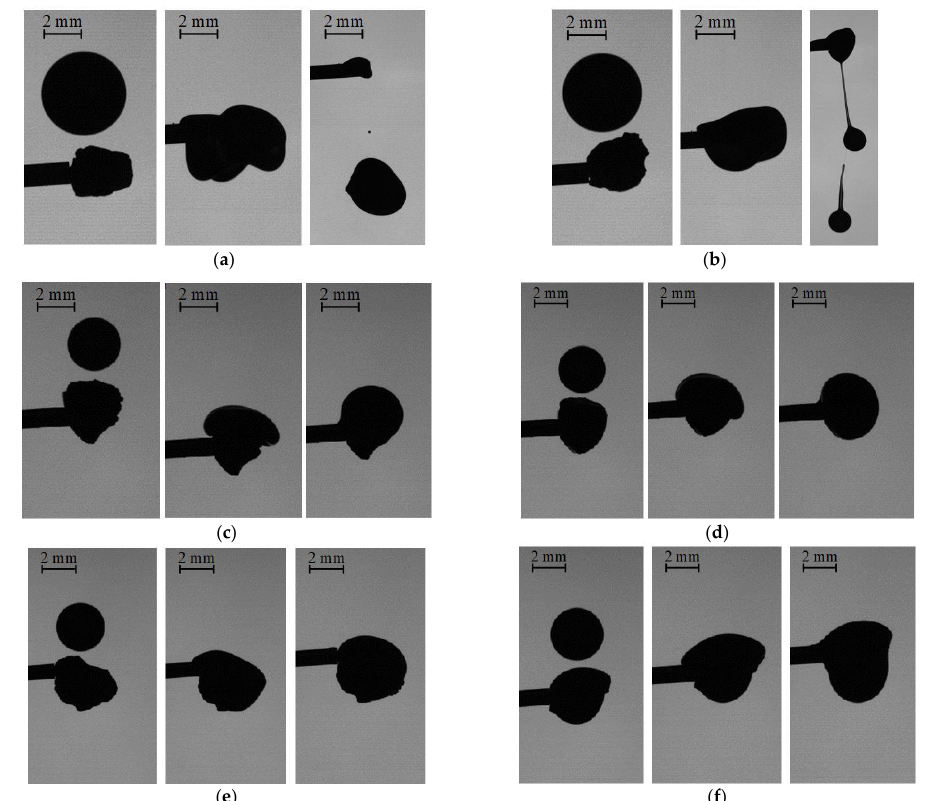
Figure 7. Images of collisions of used motor oil droplets with carbonaceous particles of anthracite at varying droplet sizes: ( a , c , e )—dry particles; ( b , d , f )—particles containing water on the surface; ( a , b )— R d = 1.45 mm; ( c , d )— R d = 1.3 mm; ( e , f )— R d = 1.1